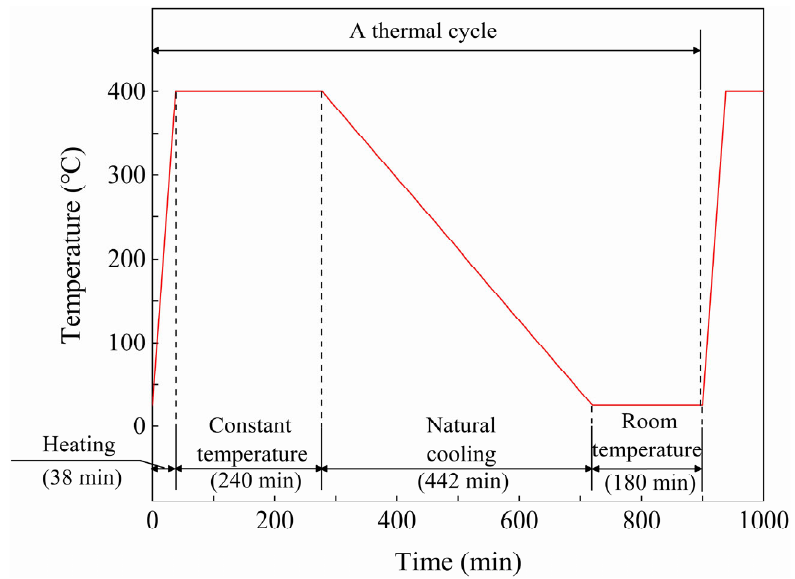
Figure 3. Temperature change curves during thermal cycle process.